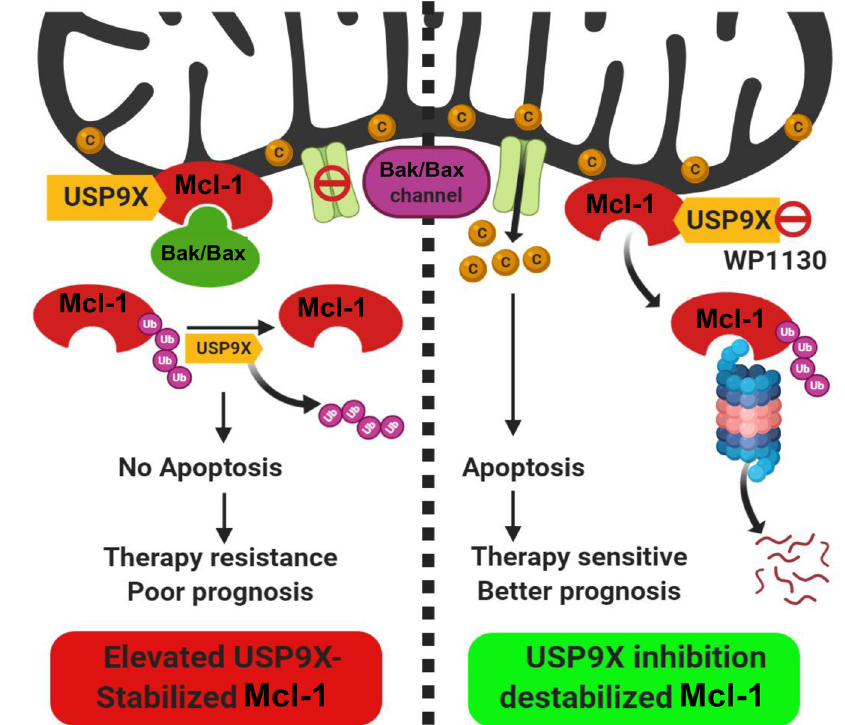
Figure 1. Posttranslational regulation of Mcl-1 protein stability by the deubiquitinase USP9X. The deubiquitinase USP9X interacts with Mcl-1 protein which localizes to the mitochondrial outer membrane. USP9X deubiquitinates and stabilizes Mcl-1 protein which in turn through interaction with BAK/BAX proteins, prevents their oligomerization. In the tumors with elevated USP9X expression, therefore apoptosis is blocked which culminates into therapy resistance and poor prognosis. Pharmacological inhibition of USP9X (with a small molecule inhibitor WP1130) causes ubiquitin-proteasome-dependent degradation of Mcl-1, causing enhanced apoptosis and better therapeutic outcome. C: cytochrome C; Ub: ubiquitin. (Figure created with